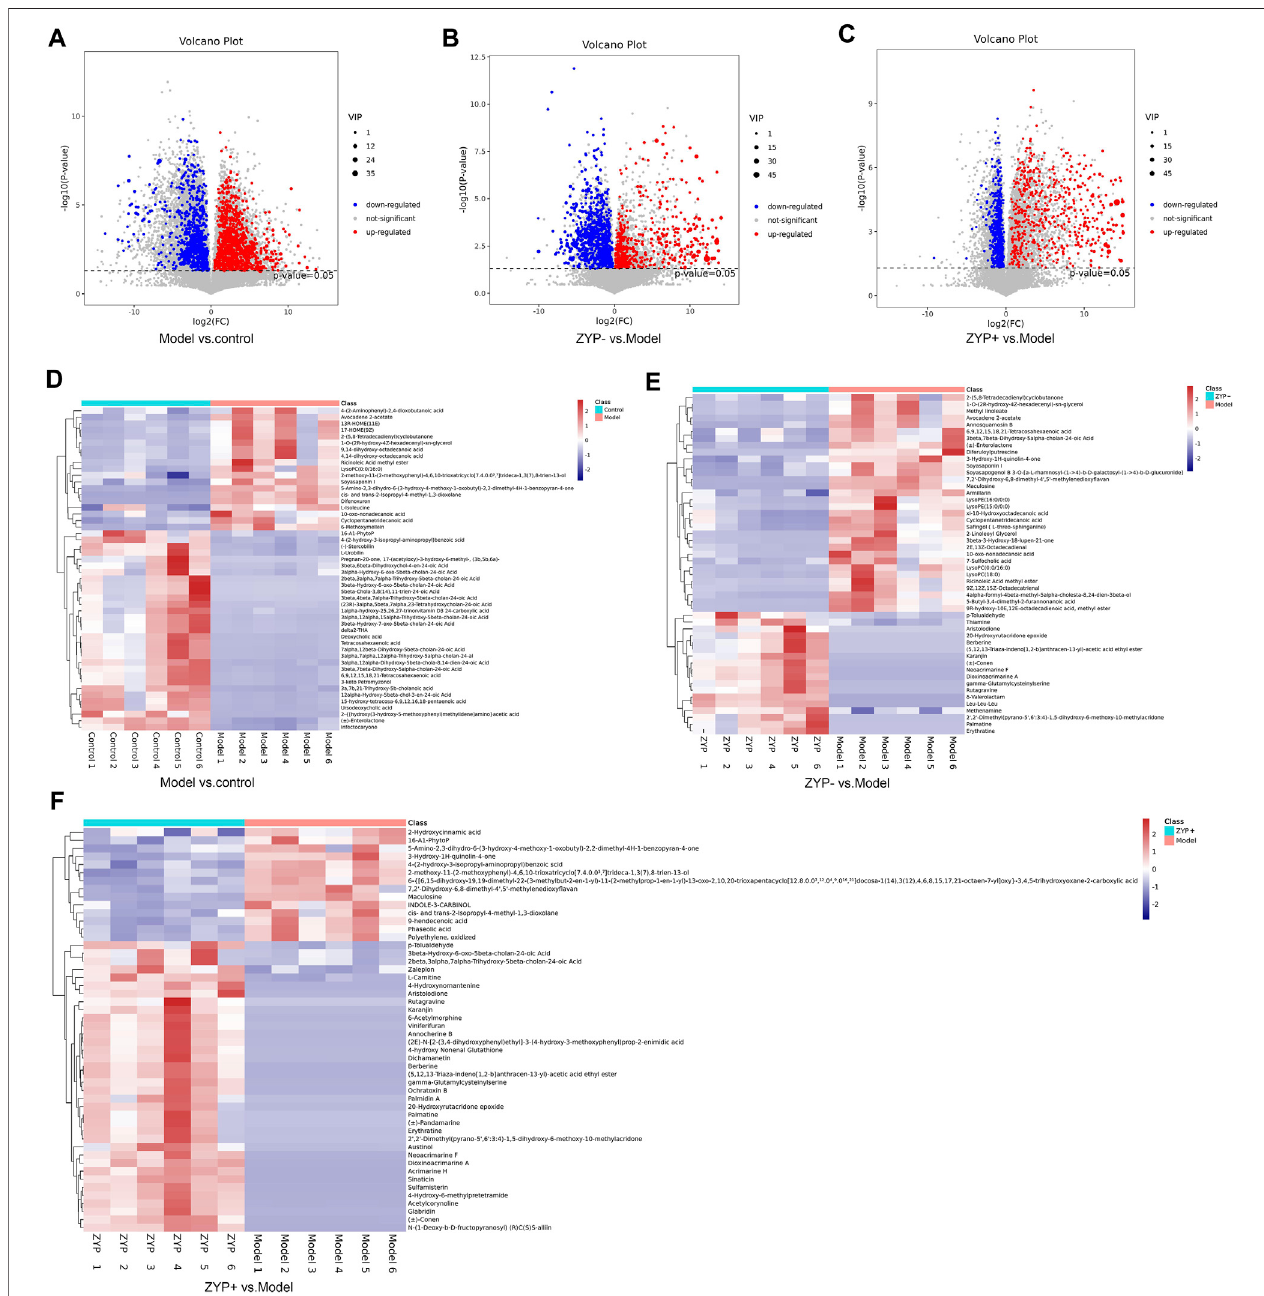
FIGURE3| Volcanoplot and Heatmap ofthedifferential metabolites. (A – C) Volcano plot ofModel vsControlgroups, ZYP − vsModel and ZYP+ vsModel groups, respectively; (D – F) Heat map of Model vs Control groups, ZYP − vs Model and ZYP+ vs Model groups, respectively. Red, blue, and gray represent the upregulated, downregulated, and non-signi fi cant changes,